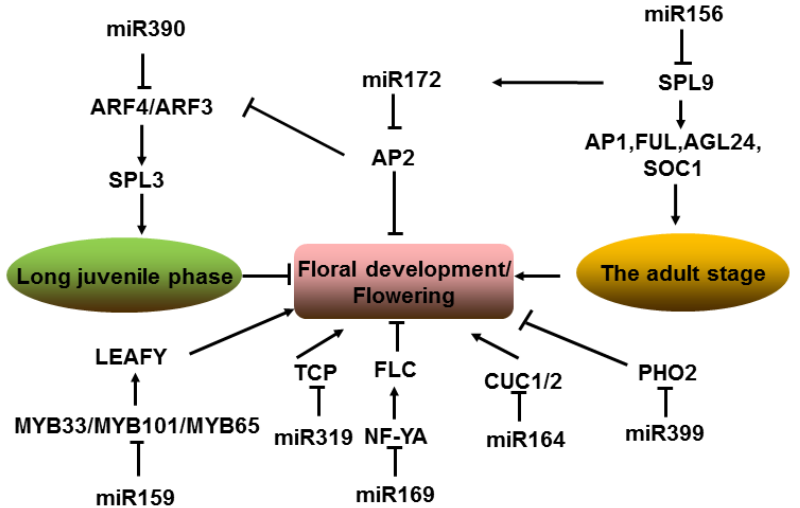
Figure 4. Pathway of miRNAs involved in plant floral development. MiR156, miR172, miR390, and their targets interact to form a complex network mediated by transcription factors. Note: → repre- sents positive regulation, and ┤ represents negative regulation.